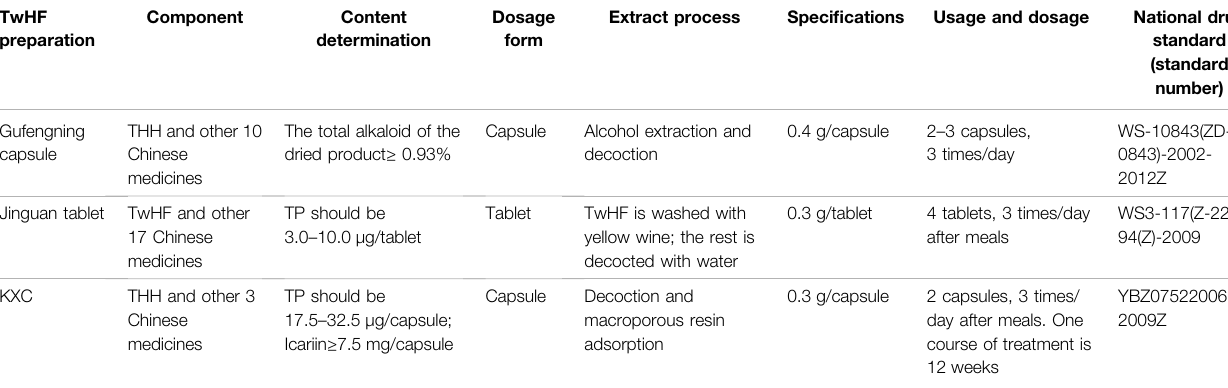
TABLE 3 | Compound TwHF